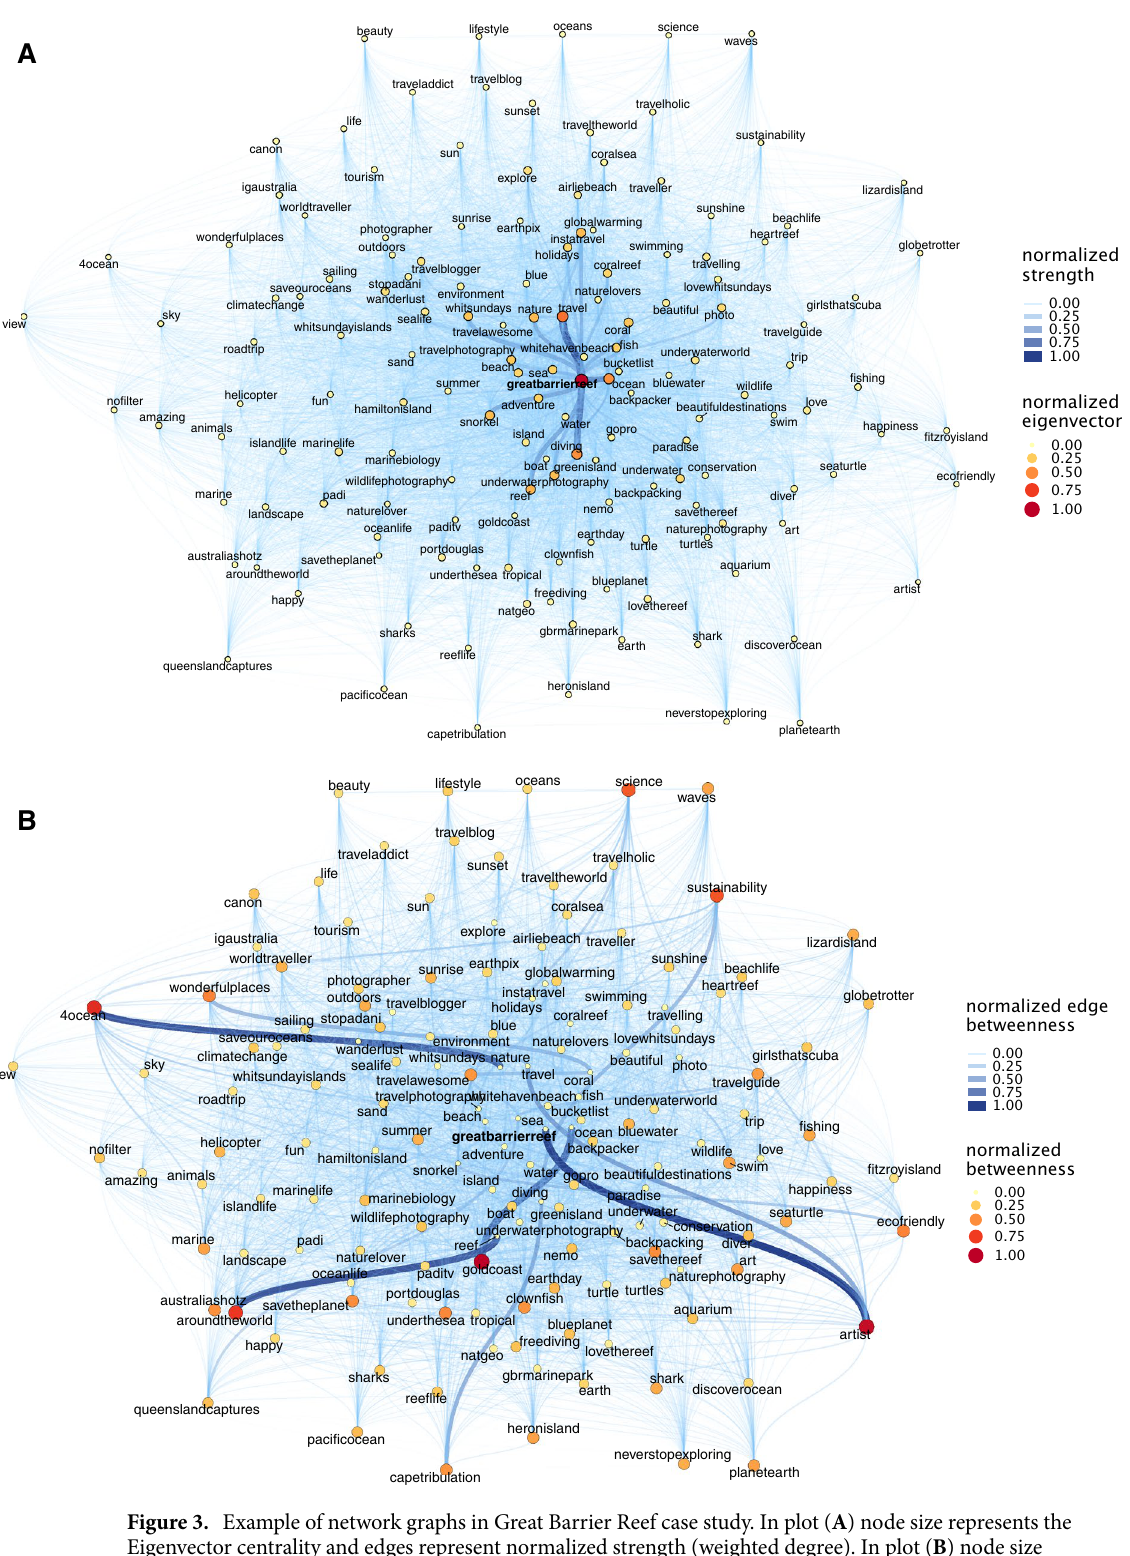
Figure 3. Example of network graphs in Great Barrier Reef case study. In plot ( A ) node size represents the Eigenvector centrality and edges represent normalized strength (weighted degree). In plot ( B ) node size represents normalized Betweenness centrality and edges represent normalized Edge